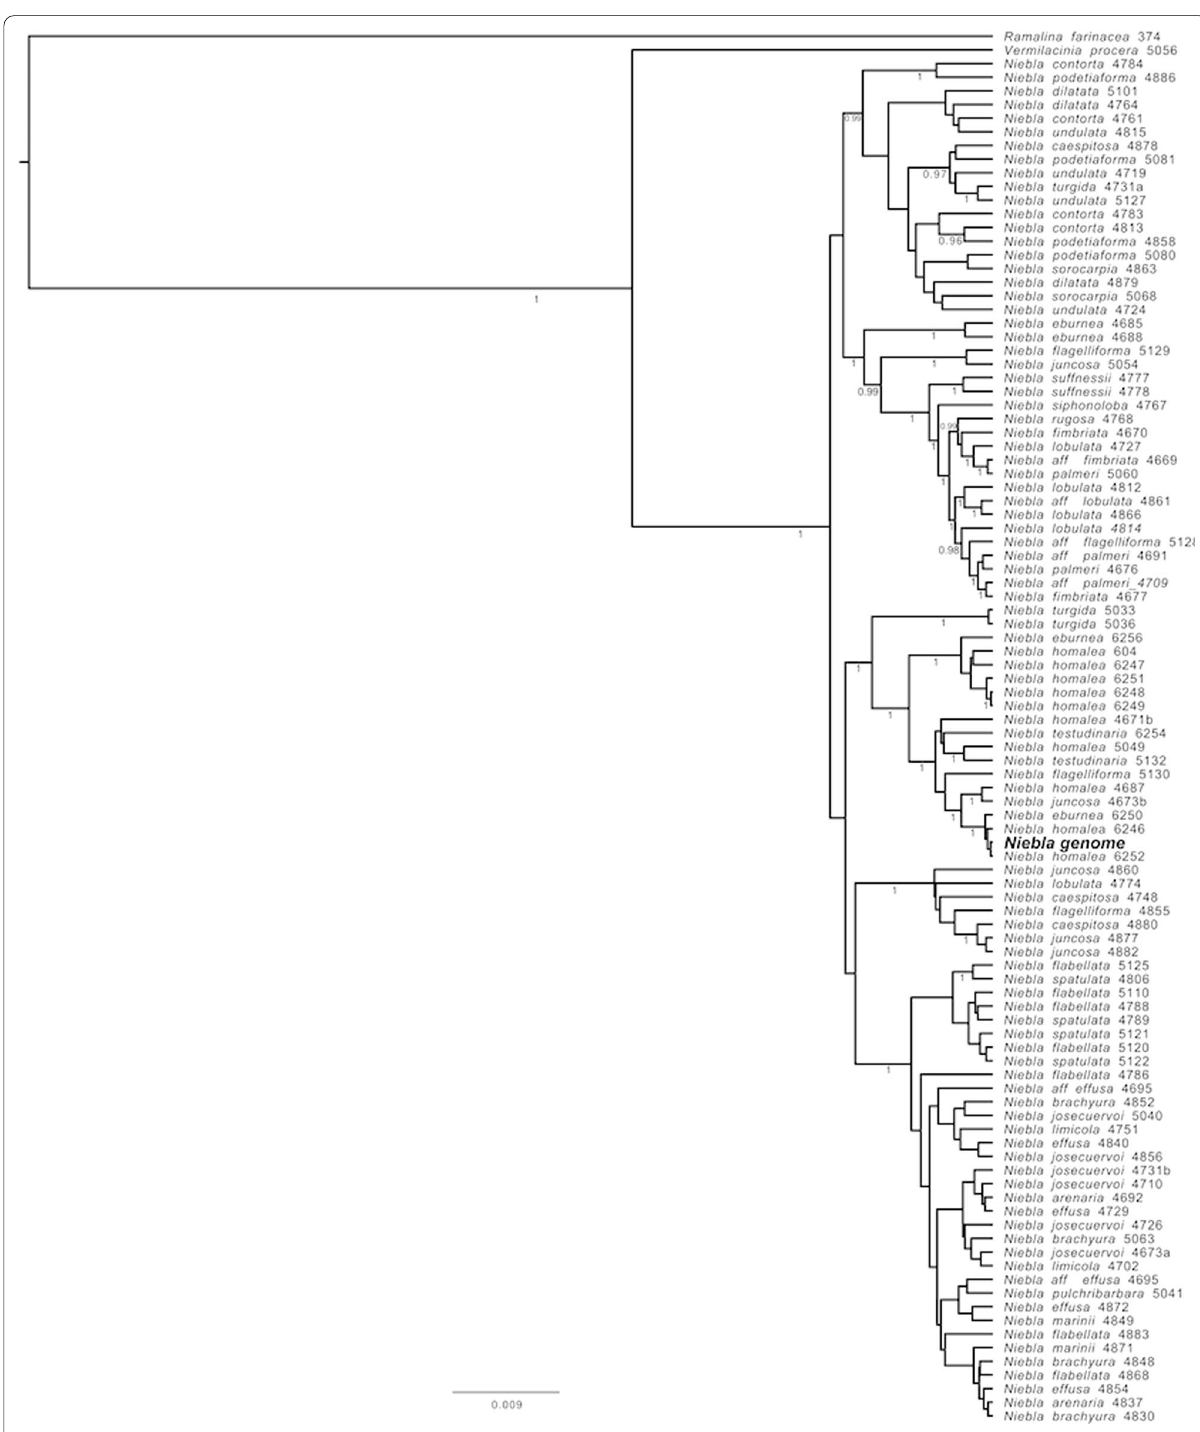
Fig. 3 Bayesian six loci phylogeny including the genome sequence of Niebla homalea (highlighted in bold as Niebla genome ). Posterior probability values above 0.95 are indicated below the branches. Ramalina farinacea and Vermilacinia procera were used as